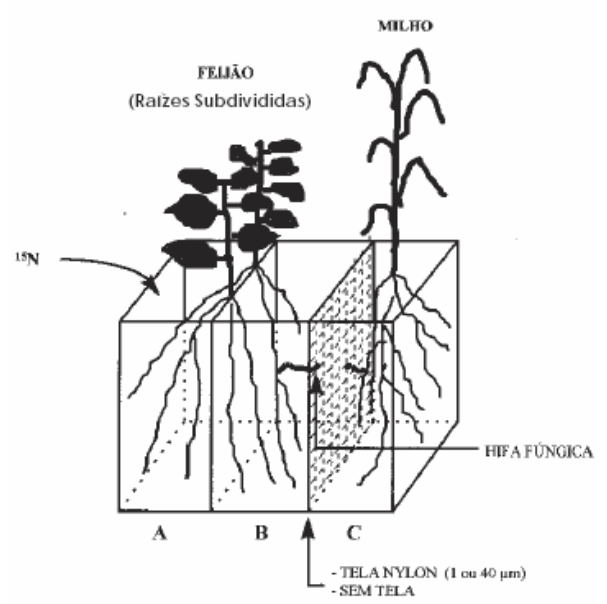
Figura 1. Esquema dos vasos utilizados no